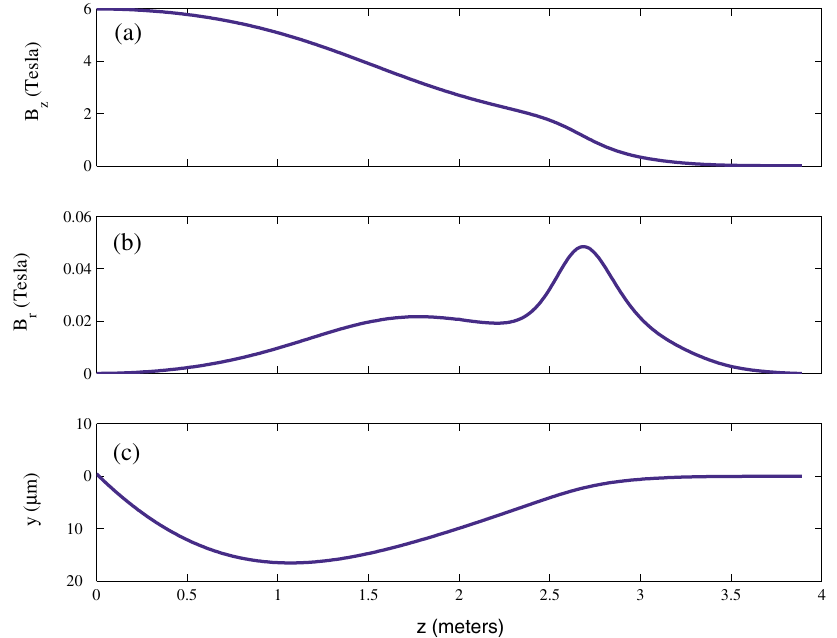
FIG. 4. (Color) Magnetic field in a prototype linear collider detector solenoid along the beam trajectory: (a) longitudinal field; (b) radial field; (c) resulting vertical deflection of a 500 GeV beam within the solenoid.